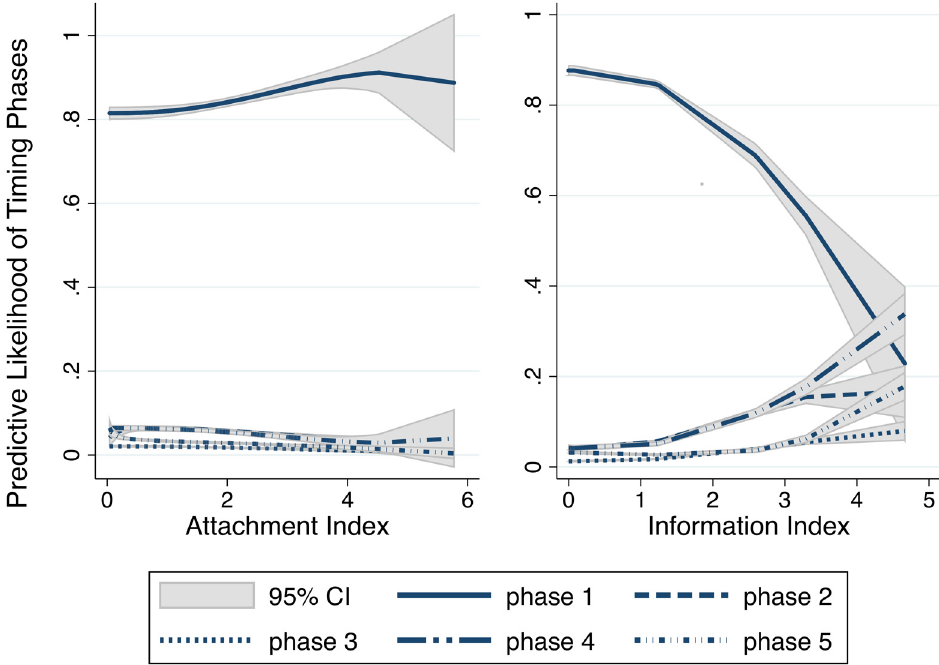
Fig 3. The marginal effects of attachment and information on the timing of application. Predicted Likelihood estimated from Model (5) of Table 2. Factor polynomial fit with 95%